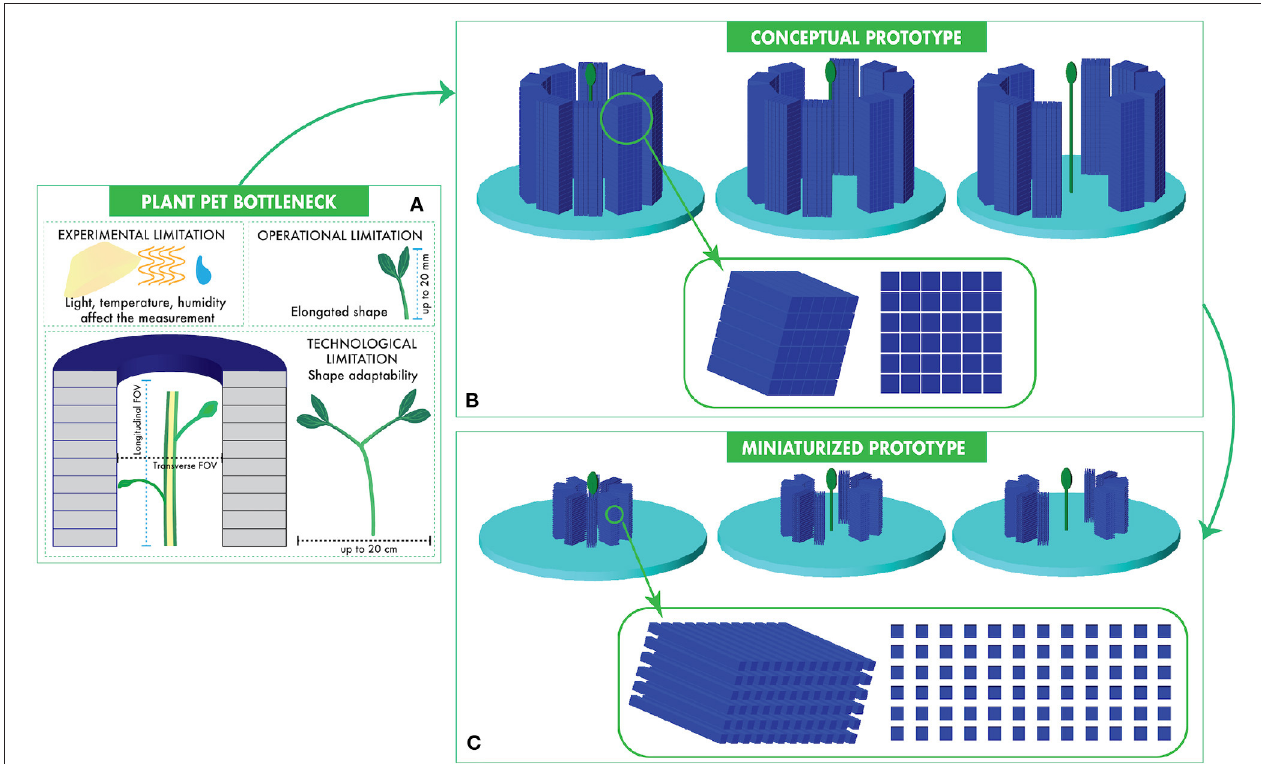
FIGURE 1 | The application of PET to agronomy is limited by experimental, operational, and technological bottlenecks (A) . We propose a new concept of a portable plant PET scanner composed of two movable half-cylinders (B) and we study its miniaturization options (C) . The main parameters of the two systems are summarized in Table 1